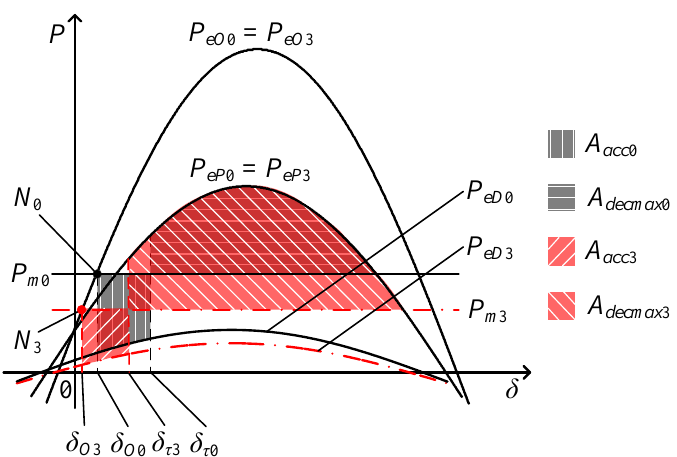
Figure 9. The comparison of the equivalent P -δ curves between the wind case operating in scenario three and the no-wind power case.